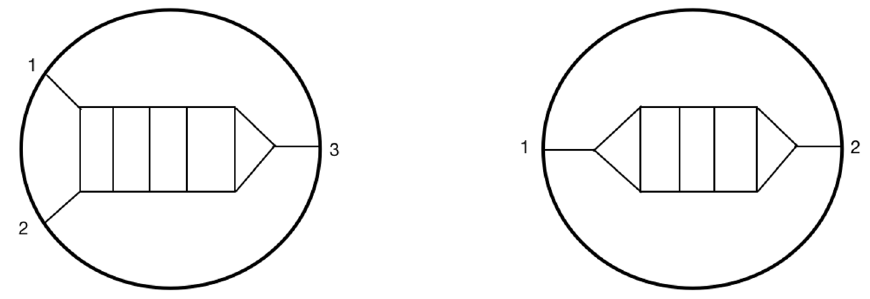
Figure 6 . Left: an example of a 3-point ladder diagram. Right: an example of a 2-point ladder